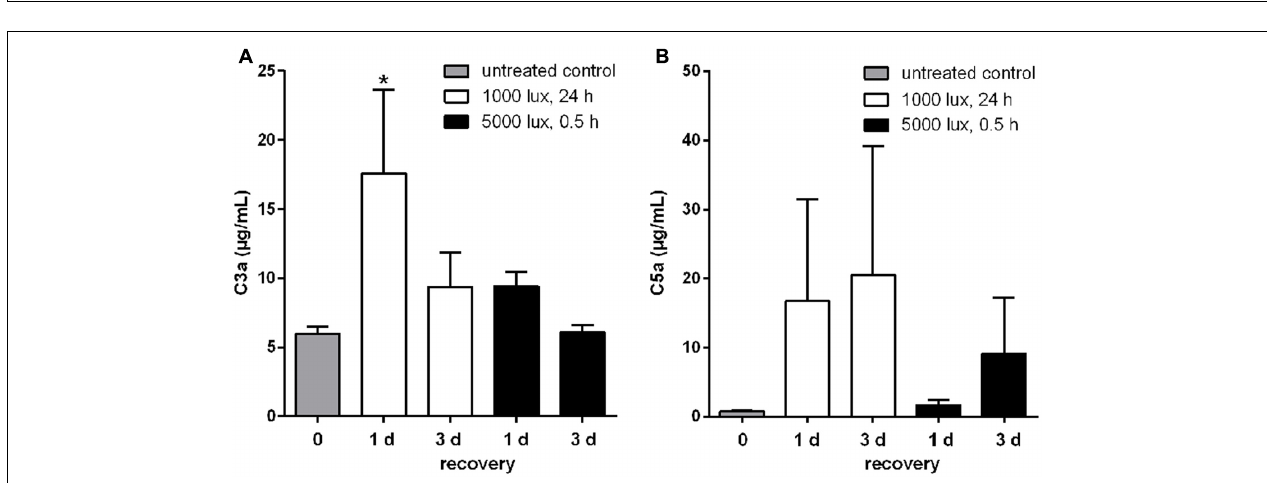
FIGURE 8 | Systemic C3a and C5a concentrations were altered in LD mice. Anaphylatoxin concentrations, (A) C3a and (B) C5a, in sera of mice treated with white light were determined in ELISA. (A) C3a and (B) C5a concentrations were elevated compared to the control group, but showed a wide concentration range and standard error within the groups. (A) Systemic C3a concentration in mice was significantly increased 1 day post-constant light treatment (1000 lux, 24 h). Data represent mean values + standard error mean of six mice. ∗ 0.01 < P < 0.05 (ordinary one-way ANOVA, Dunnett’s multiple comparisons test, with a single pooled